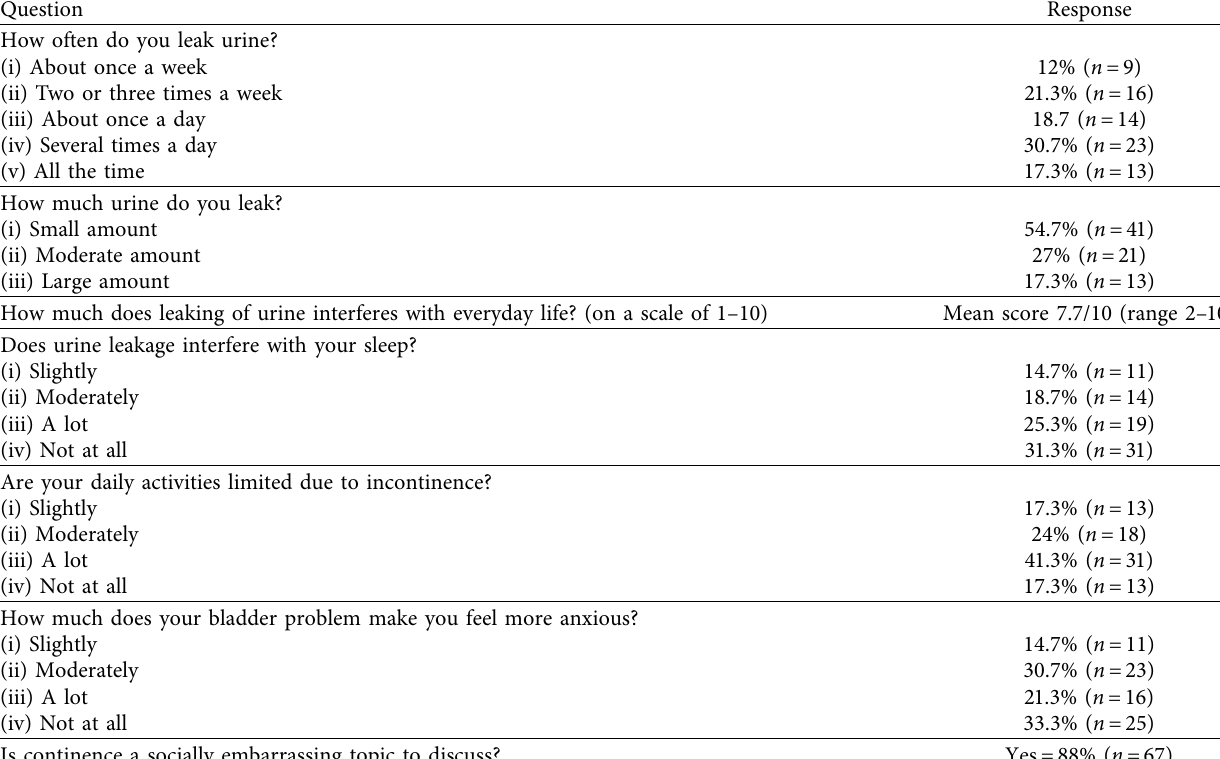
Table 2: Responses of persons with dementia to question